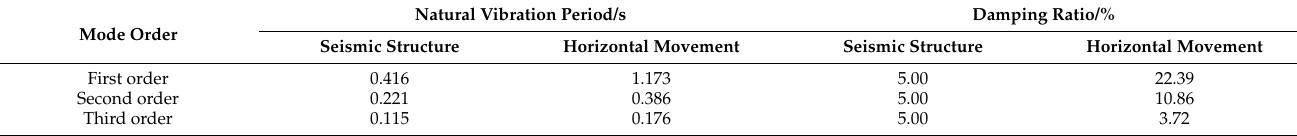
Table 4. Comparison of analysis results of first three-order self-vibration characteristics of structure. Mode Order